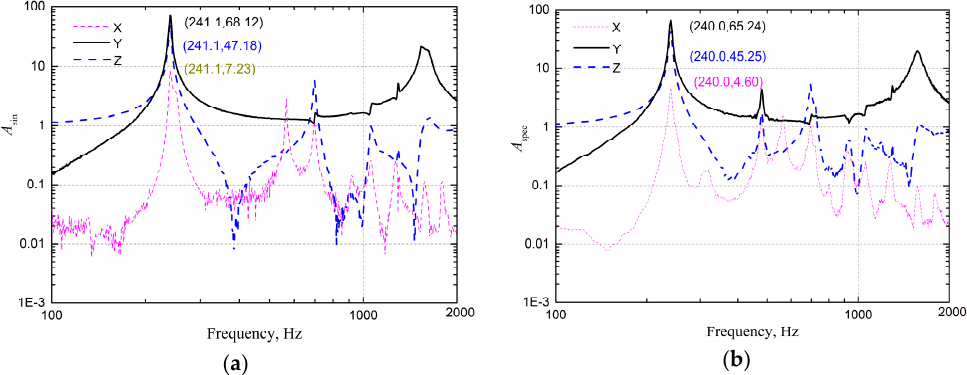
Figure 7. The frequency response function of Sup_1: ( a ) Sinusoidal excitation; ( b ) Random excitation.